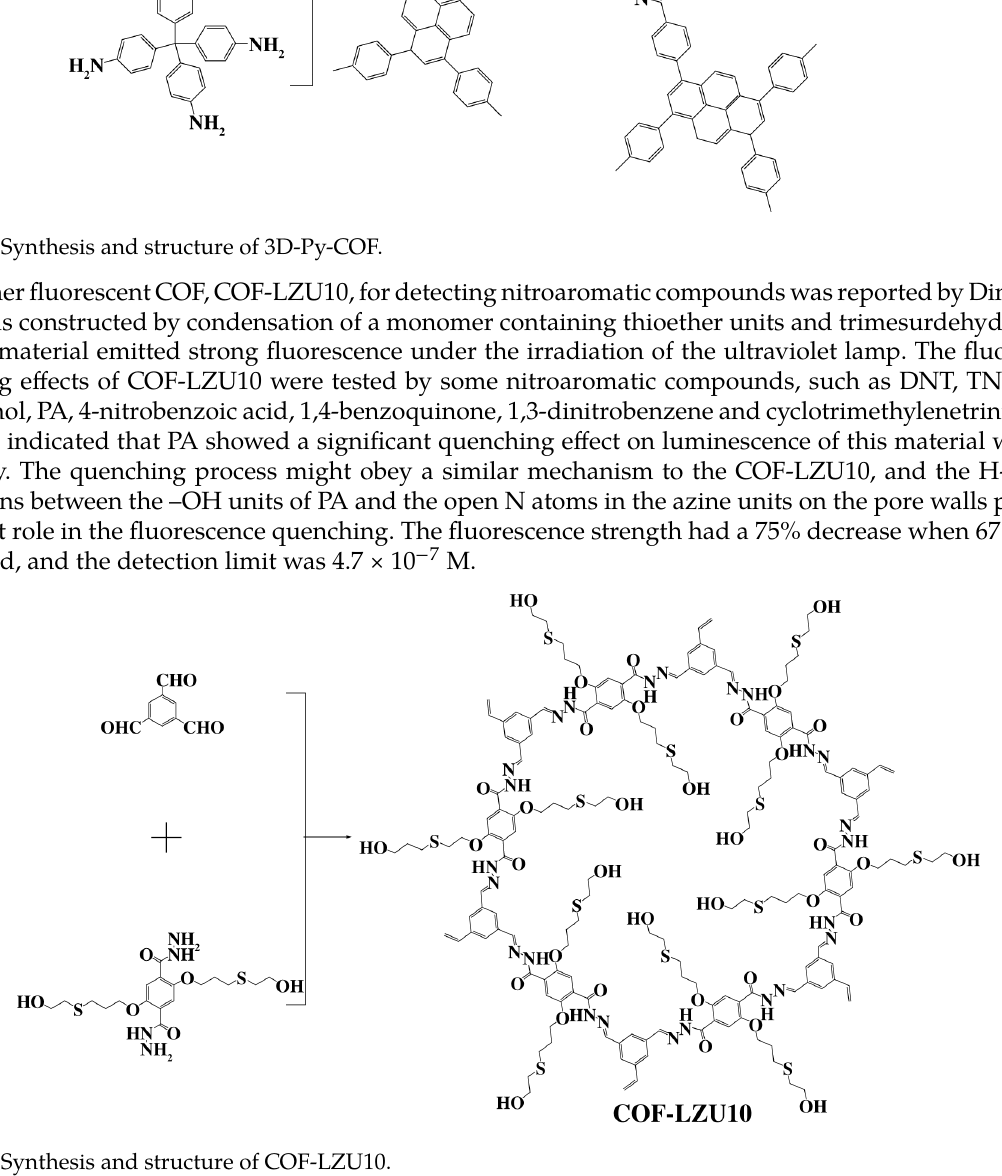
Figure 16: Synthesis and structure of